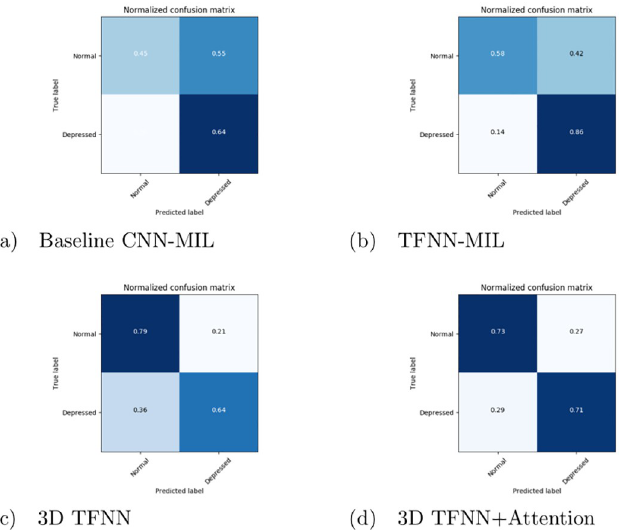
Fig 3. Normalized confusion matrix for the test set of DAIC-WOZ depression dataset for the three architectures —Baseline CNN-MIL, TFNN-MIL, 3D TFNN and 3D TFNN+Attention.